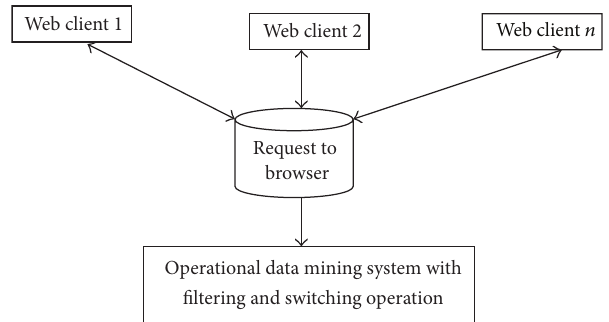
Figure 1: End-to-end query result fetching using data mining